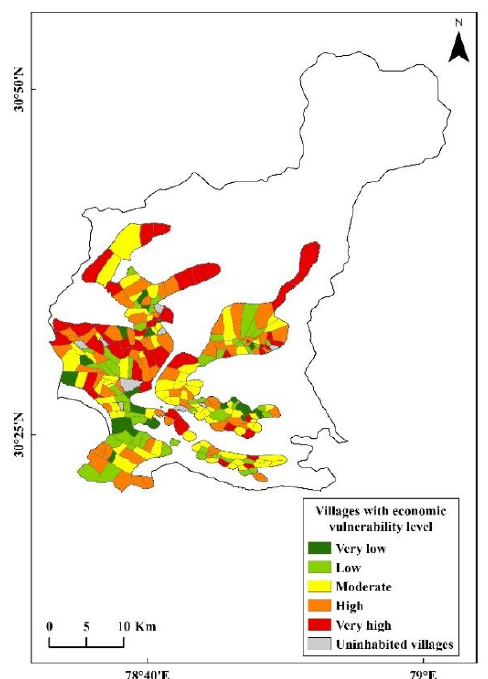
Figure 1. Economic vulnerability index distribution across the